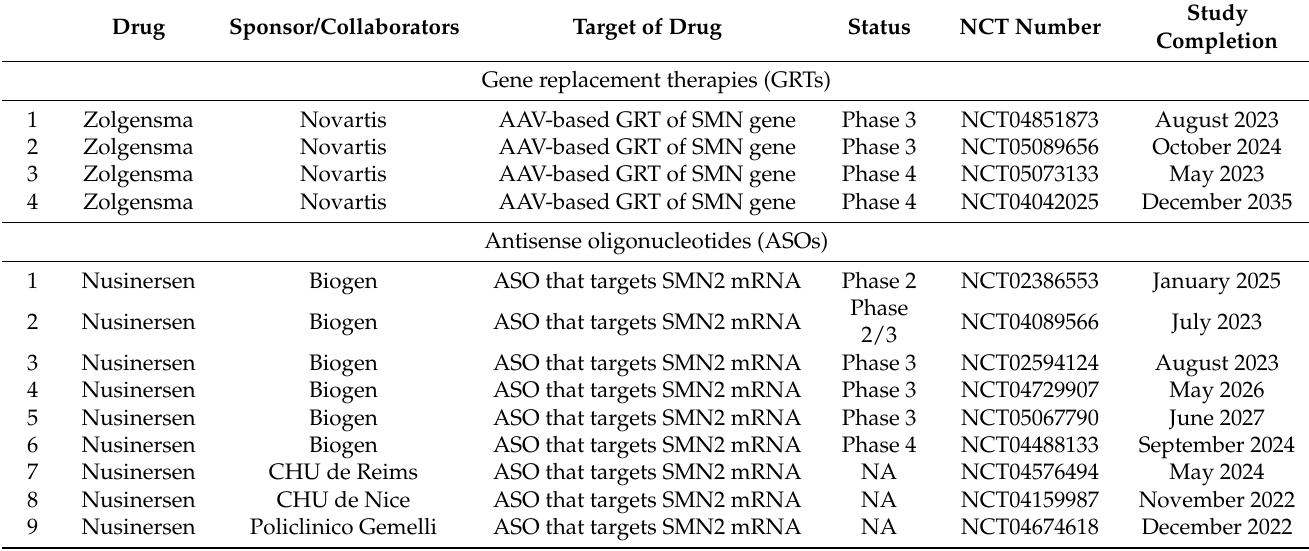
Table 2. Gene-specific therapies for SMA tested in clinical